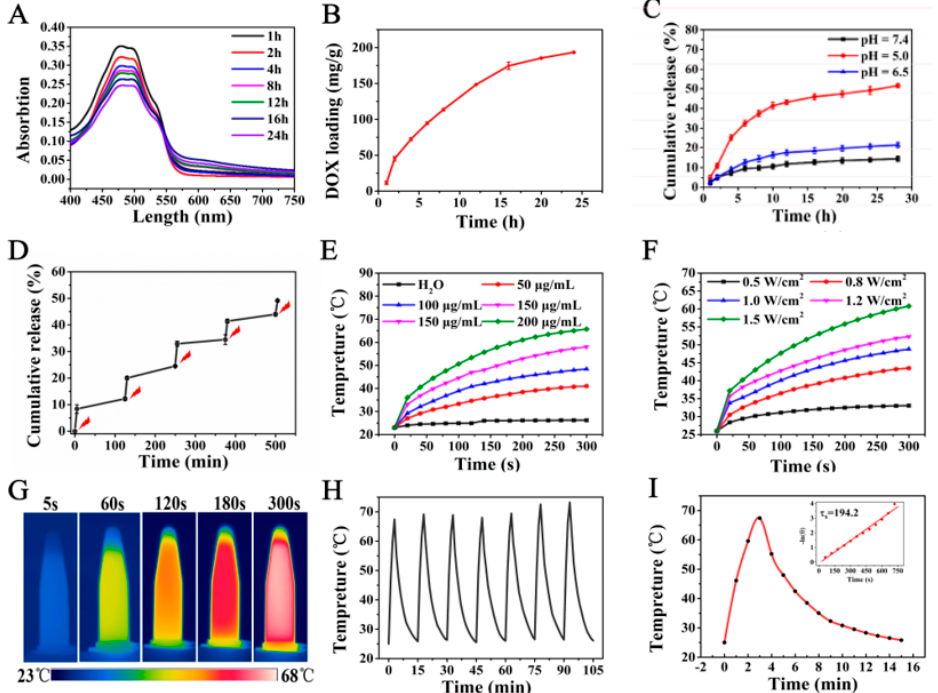
Figure 2. ( A ) UV − visible absorption spectra of DOX in the supernatant at different time. ( B ) Plot of DOX loading amount for MNC@ND-DOX versus different time. ( C ) DOX release from MNC@ND- DOX NPs in buffers at the different pH values (5.0, 6.5 and 7.4). ( D ) DOX release from MNC@ND-DOX NPs at the NIR irradiation (pH = 5.0). ( E ) Temperature change curves of MNC@ND solutions with different concentrations under 808 nm NIR laser irradiation (1 W/cm 2 , 5 min) ( F ) Effects of varying laser − irradiation power at MNC@ND-DOX NPs concentration of 100 μ g/mL are shown. ( G ) Photothermal imaging of varying time of MNC@ND-DOX NPs (200 μ g/mL) under laser − irradiation. ( H ) The photothermal stability of MNC@ND-DOX solution (200 μ g/mL) irradiated under an 808 nm laser at 1.0 W/cm 2 for 300 s, then the laser was turned off. ( I ) The photothermal response of MNC@ND solution irradiated under an 808 nm laser at 1.5 W/cm 2 for 180 s, then the laser was turned off, insert is linearity curves fitted from the temperature cooling time vs − ln( θ ) of MNC@ND (200 μ g/mL 1.0 W/cm 2 ).